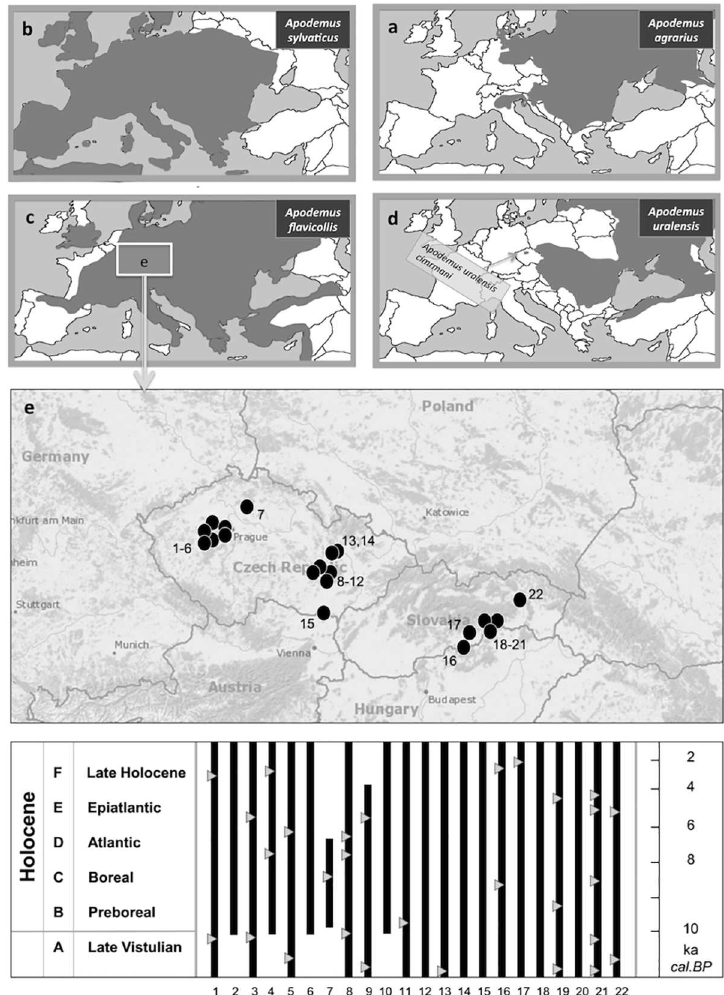
Fig 1. The current European ranges of Apodemus agrarius (a), A . sylvaticus (b), A . flavicollis (c), and A . uralensis (d); geographic position of the source sedimentary sequences of the studied fossil material (e), and their stratigraphical span (with available 14C data–triangles). Source data for (a)-(d) taken from